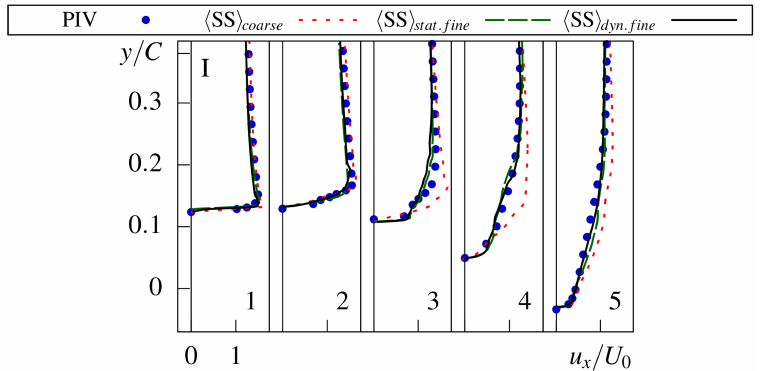
Figure 6. Comparison of experimental and numerical profiles of the streamwise component of averaged velocity for regime I. Results of Schnerr–Sauer (SS) model are presented for conditional averaging procedure with threshold value of ˜ α th = 0.25 together for coarse, mesh with dynamic refinement, and mesh with static refinement.